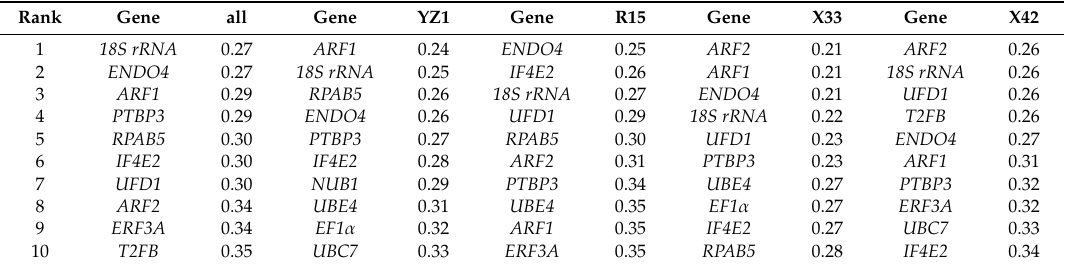
Table 2. Expression stability of the 15 candidate reference genes calculated by geNorm (M) a